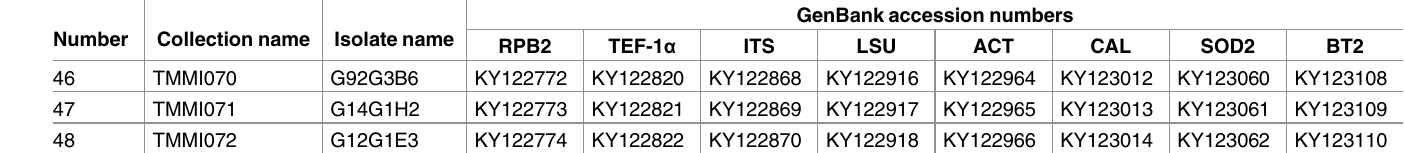
used for genetic variation and relationship analysis together with ß-tubulin exons 5 and 6